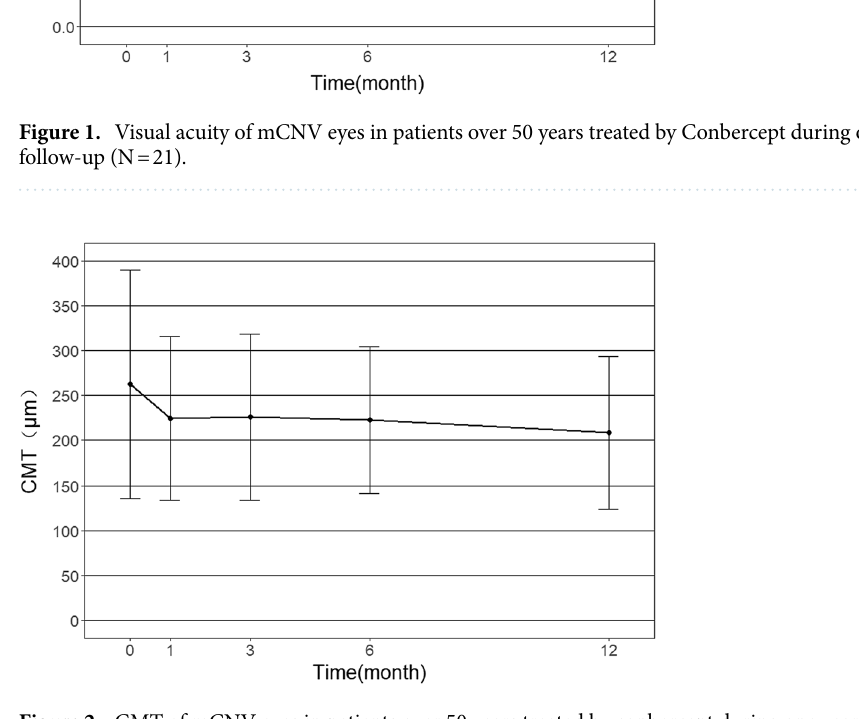
Figure 2. CMT of mCNV eyes in patients over 50 years treated by conbercept during one year follow-up (N =